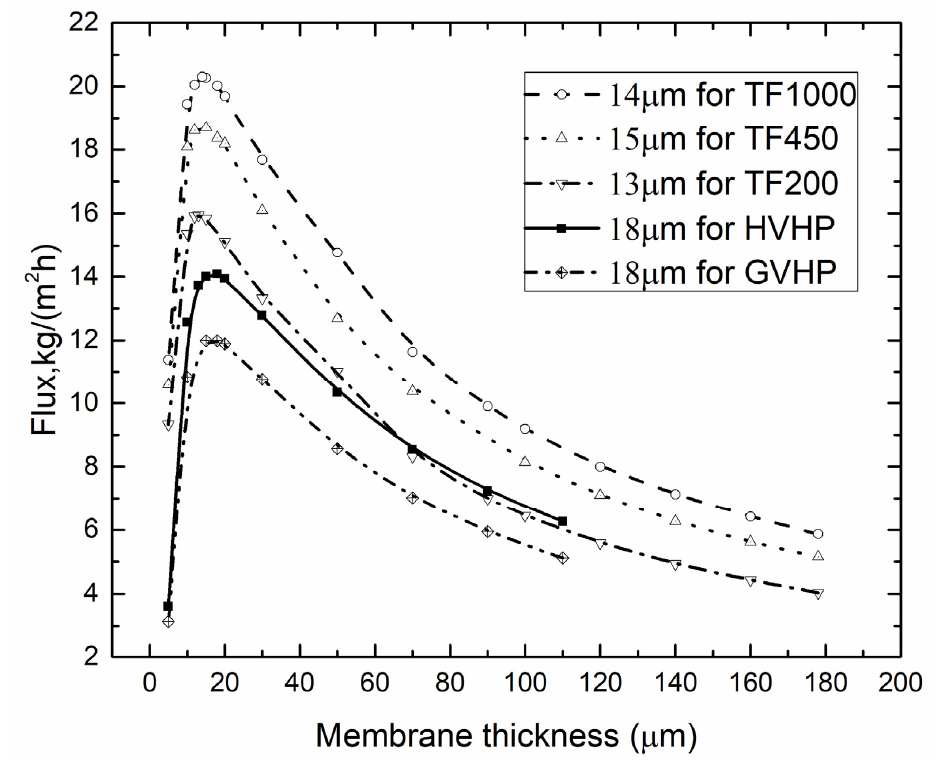
Figure 12. Optimal membrane thickness for different membrane materials ( T f = 45 °C, T p = 25 °C, v f , v p = 0.15m/s, c f = 24.2 wt.%). Membranes 2020 , 10 , x FOR PEER REVIEW